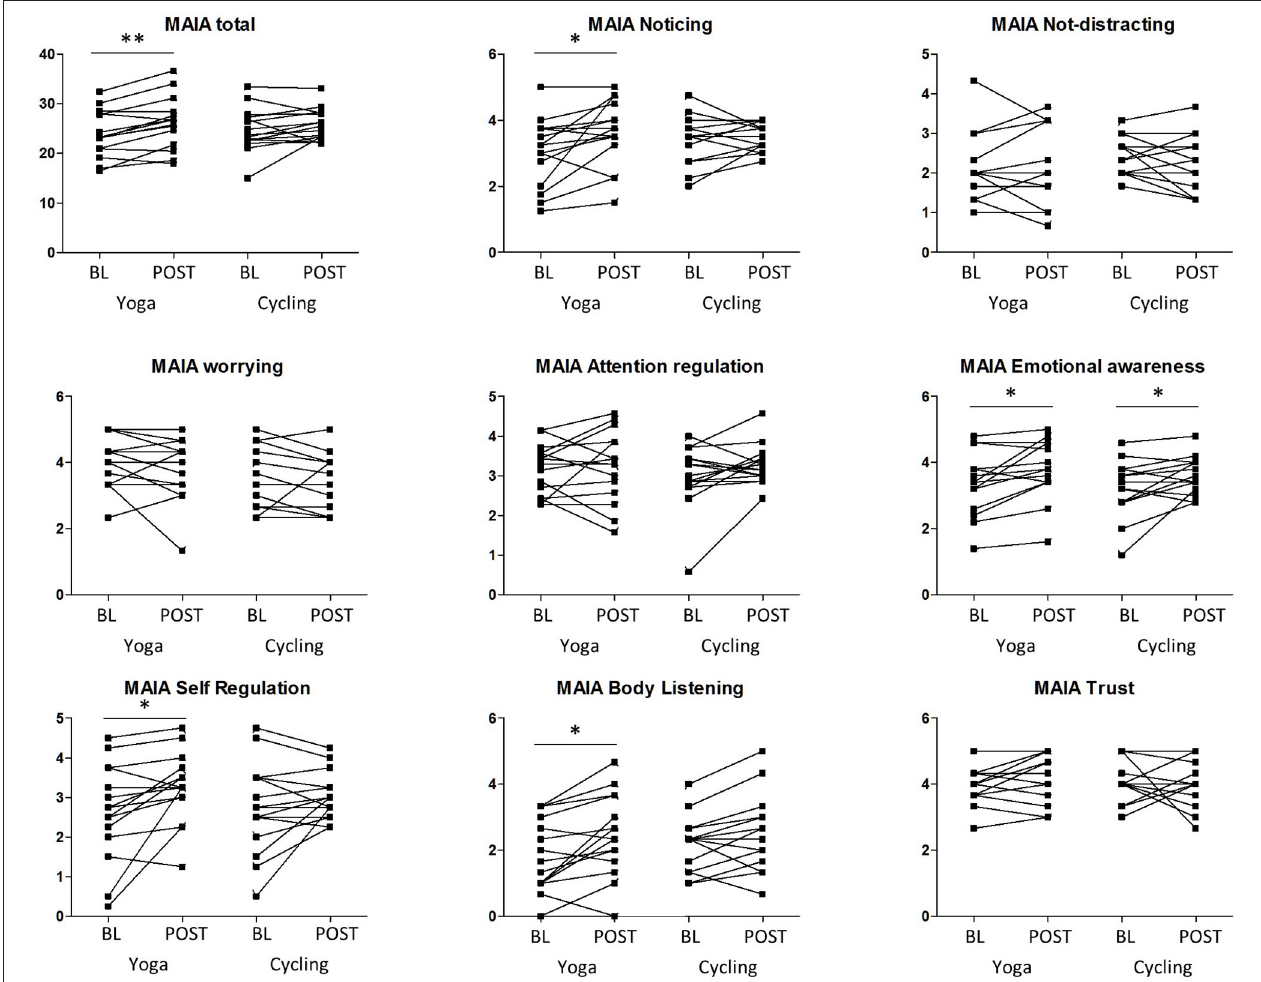
FIGURE 1 | Results of the multidimensional assessment of interoceptive awareness (MAIA) scale and subscales of both groups (yoga and cycling), at baseline (BL) and post-intervention (POST). Significant results of the paired tests are indicated with * ( P < 0.05, uncorrected) and ** ( P < 0.005,